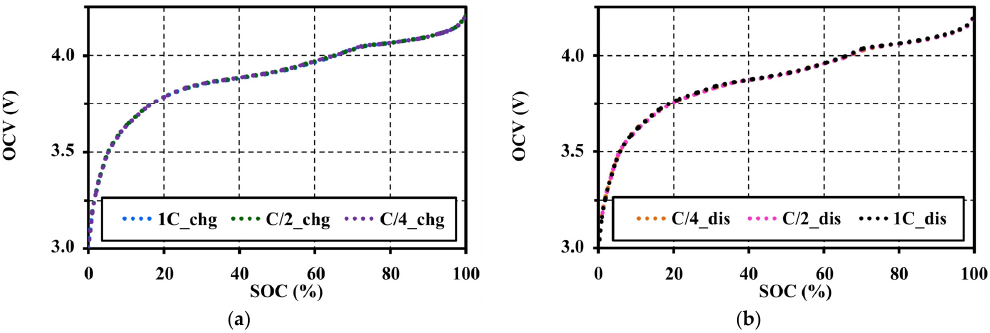
Figure 7. Effects of pulse current amplitudes on the OCV characteristic at 20 °C with 60 min resting: ( a ) under the charge test; and ( b ) under the discharge test.